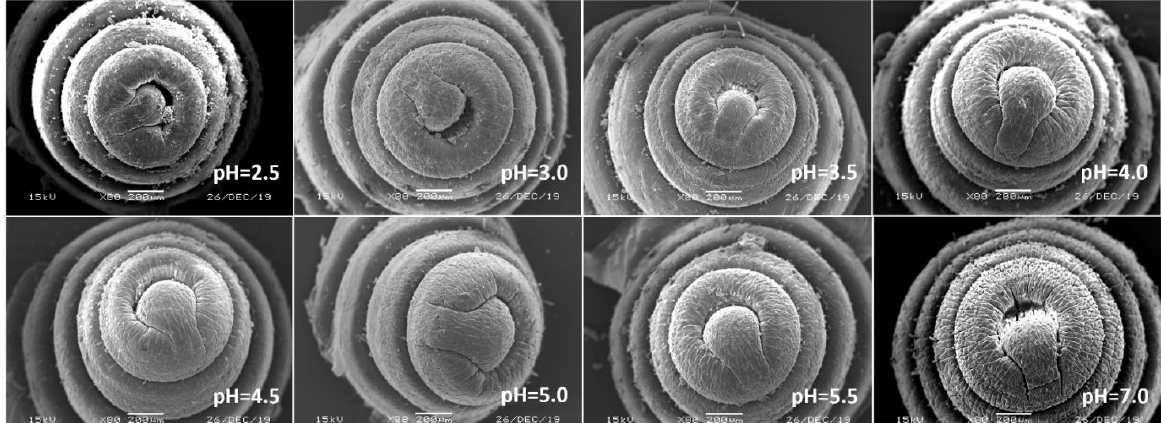
Figure 4. Prostomium of adult Eisenia fetida on filter paper under acid rain with eight pH levels for 72 h ( n = 10). Treatments: pH 7.0: control, pH 2.0–5.5: acid rain with different pH levels.